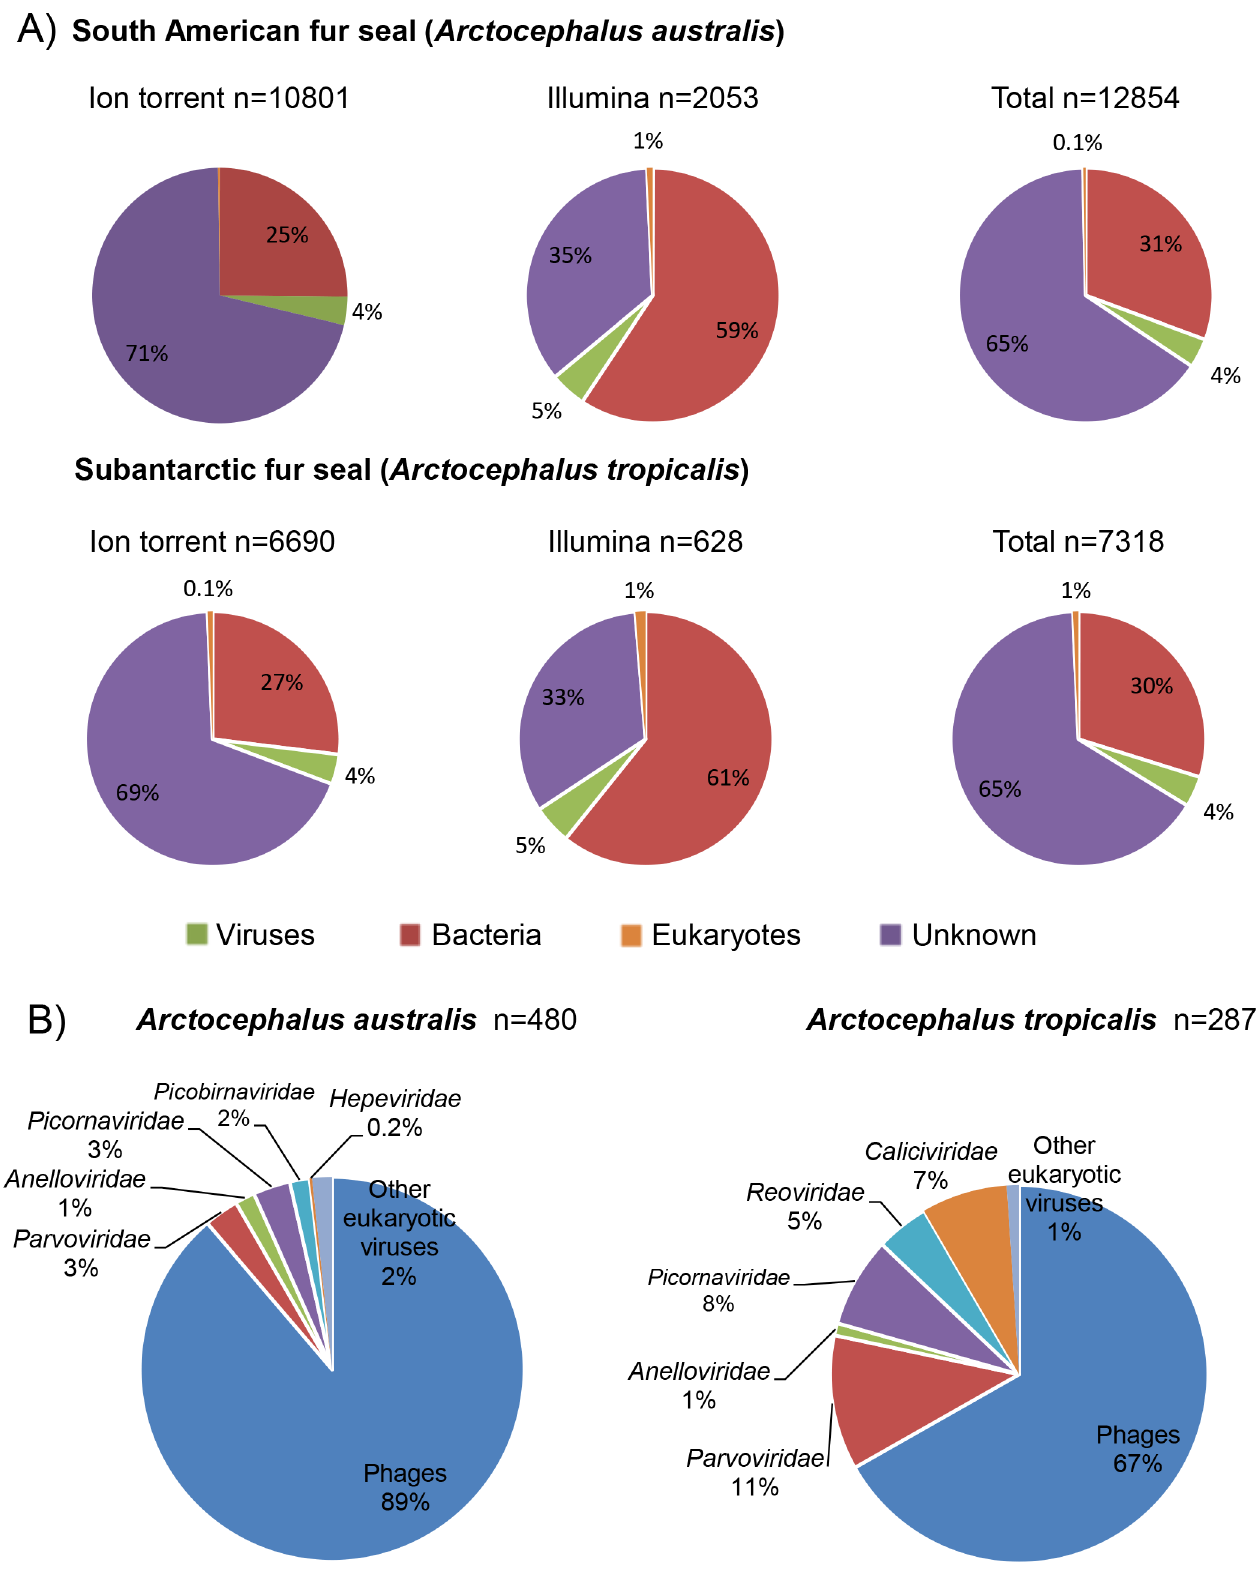
Fig 2. Taxonomic classification of assembled reads ( > 100bp). (A) Pie charts of assembled reads based on BLASTx best E-scores (cutoff: 10e-05) against the GenBank non-redundant and viral databases. (B) Taxonomic distribution of viruses for each fur seal species. doi:10.1371/journal.pone.0151921.g002 PLOS ONE | DOI:10.1371/journal.pone.0151921 March 17,